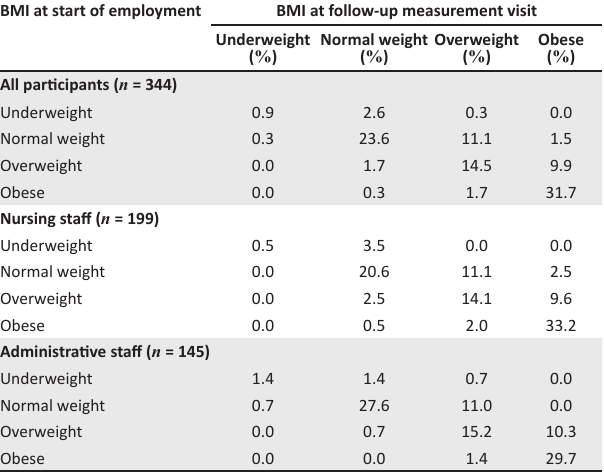
TABLE 3 : Comparison of body mass index at the start of employment and body TABLE 5 : The association between body mass index and sickness absenteeism mass index at the time of the study. ( n = BMI at start of employment BMI at follow-up measurement visit Underweight Normal weight Overweight ( % ) ( % ) ( % )